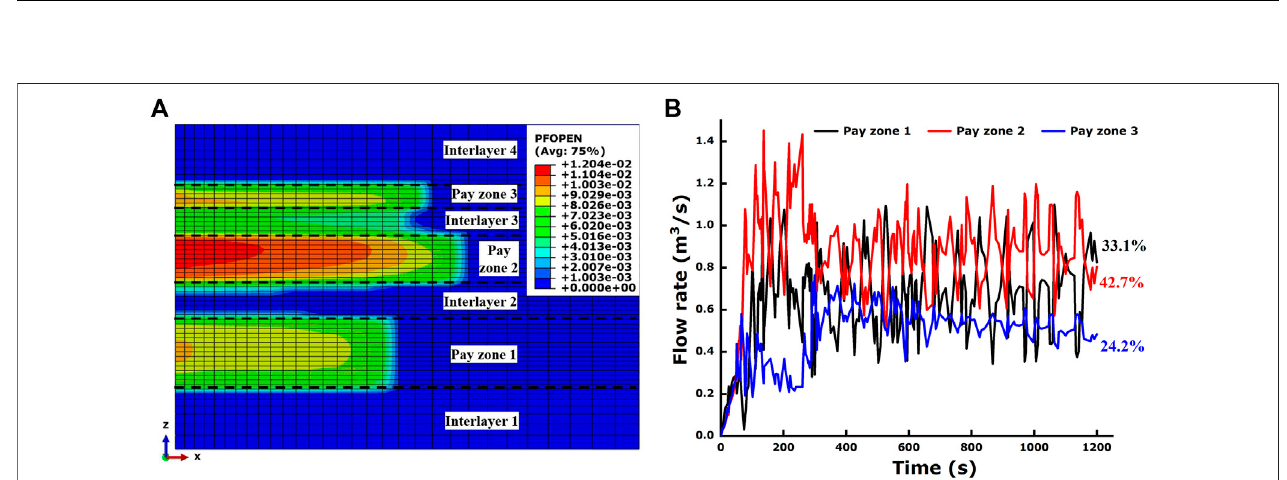
FIGURE 13 | Fracture geometry and fl ow rates of the fl uid into pay zones with new minimum horizontal stress of pay zones. (A) Hydraulic fracture geometry; (B) Flow rates of fl uid into the three pay zones.